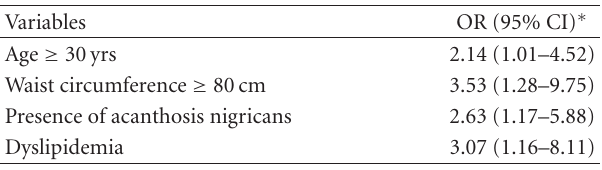
Table 4: Independence predictors for insulin resistance in 250 Thai women with polycystic ovary